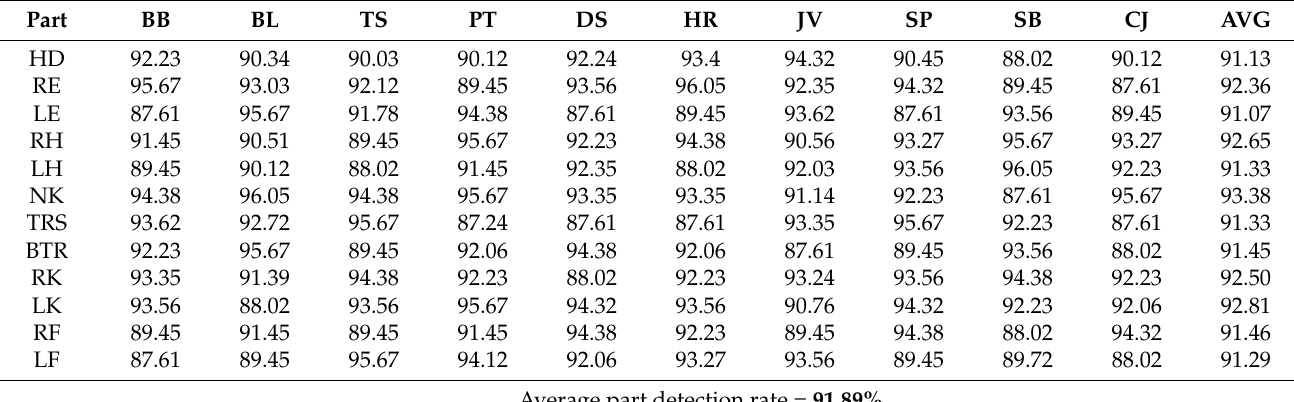
Table 3. Body part detection rate achieved over Olympic Sports dataset.